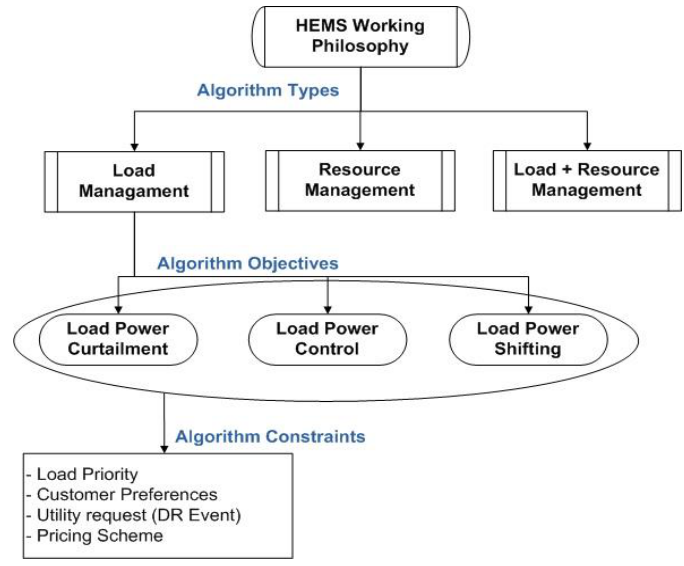
Figure 1. Classification of home energy management systems (HEMS).